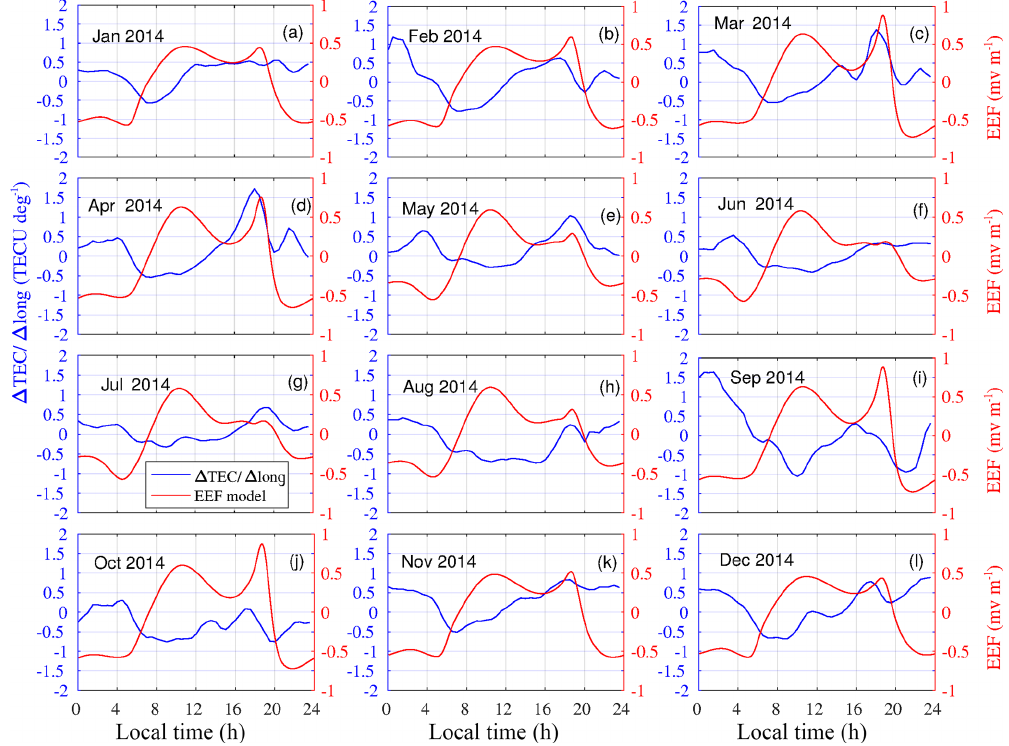
Figure 2. Comparison of quiet-monthly mean of EEF derived from real-time electric field model at ∼ 40 ◦ E and spatial gradient of TEC between ASAB and DEBK in the year